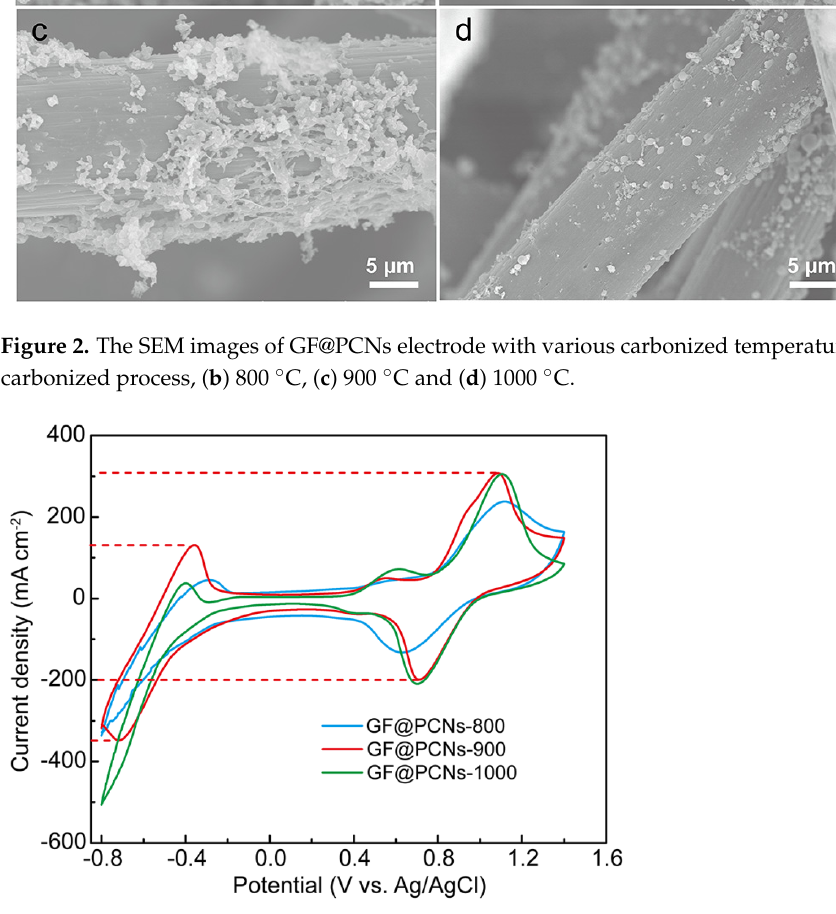
Figure 3. CV curves of GF@PCNs-800, GF@PCNs-900 and GF@PCNs-1000.